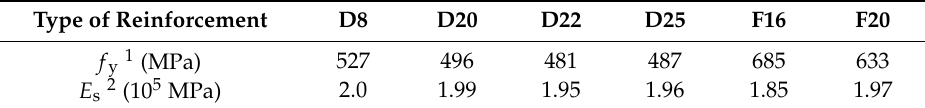
Table 3. Mechanical properties of steel